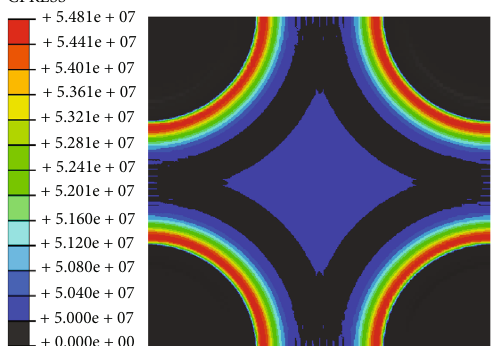
Figure 19: Contact stress nephogram of rock